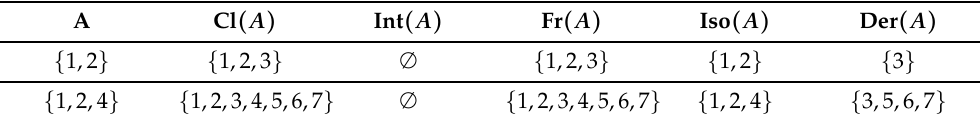
Table 1. Classification in the Fano Plane.